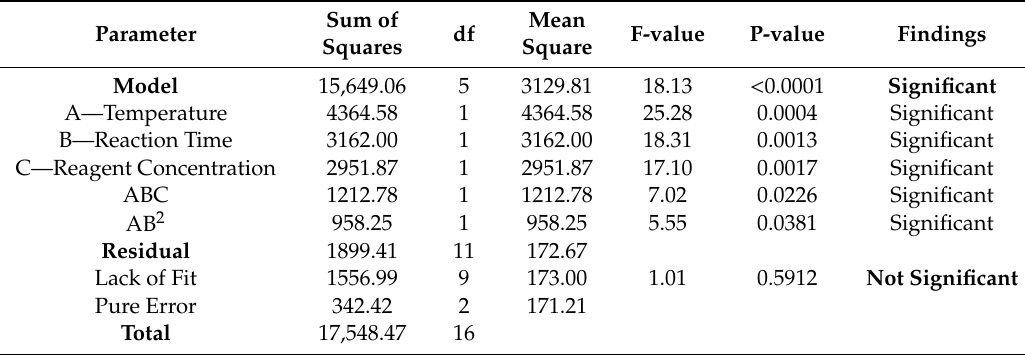
Table A2. Actual Analysis of Variance (ANOVA) results obtained from Design Expert